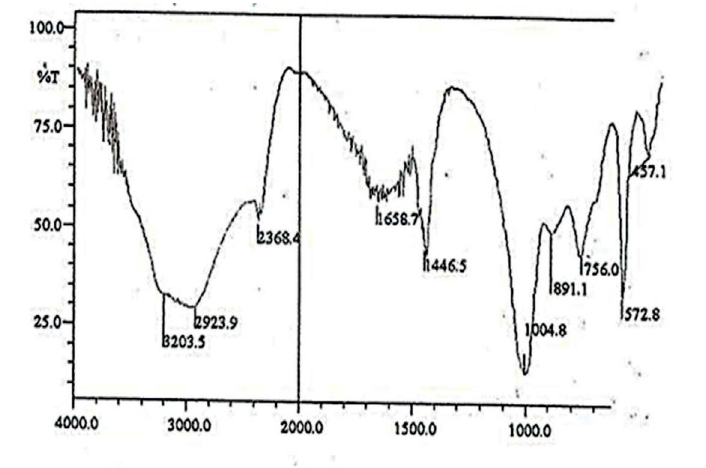
Fig. 4. IR spectrum of struvite